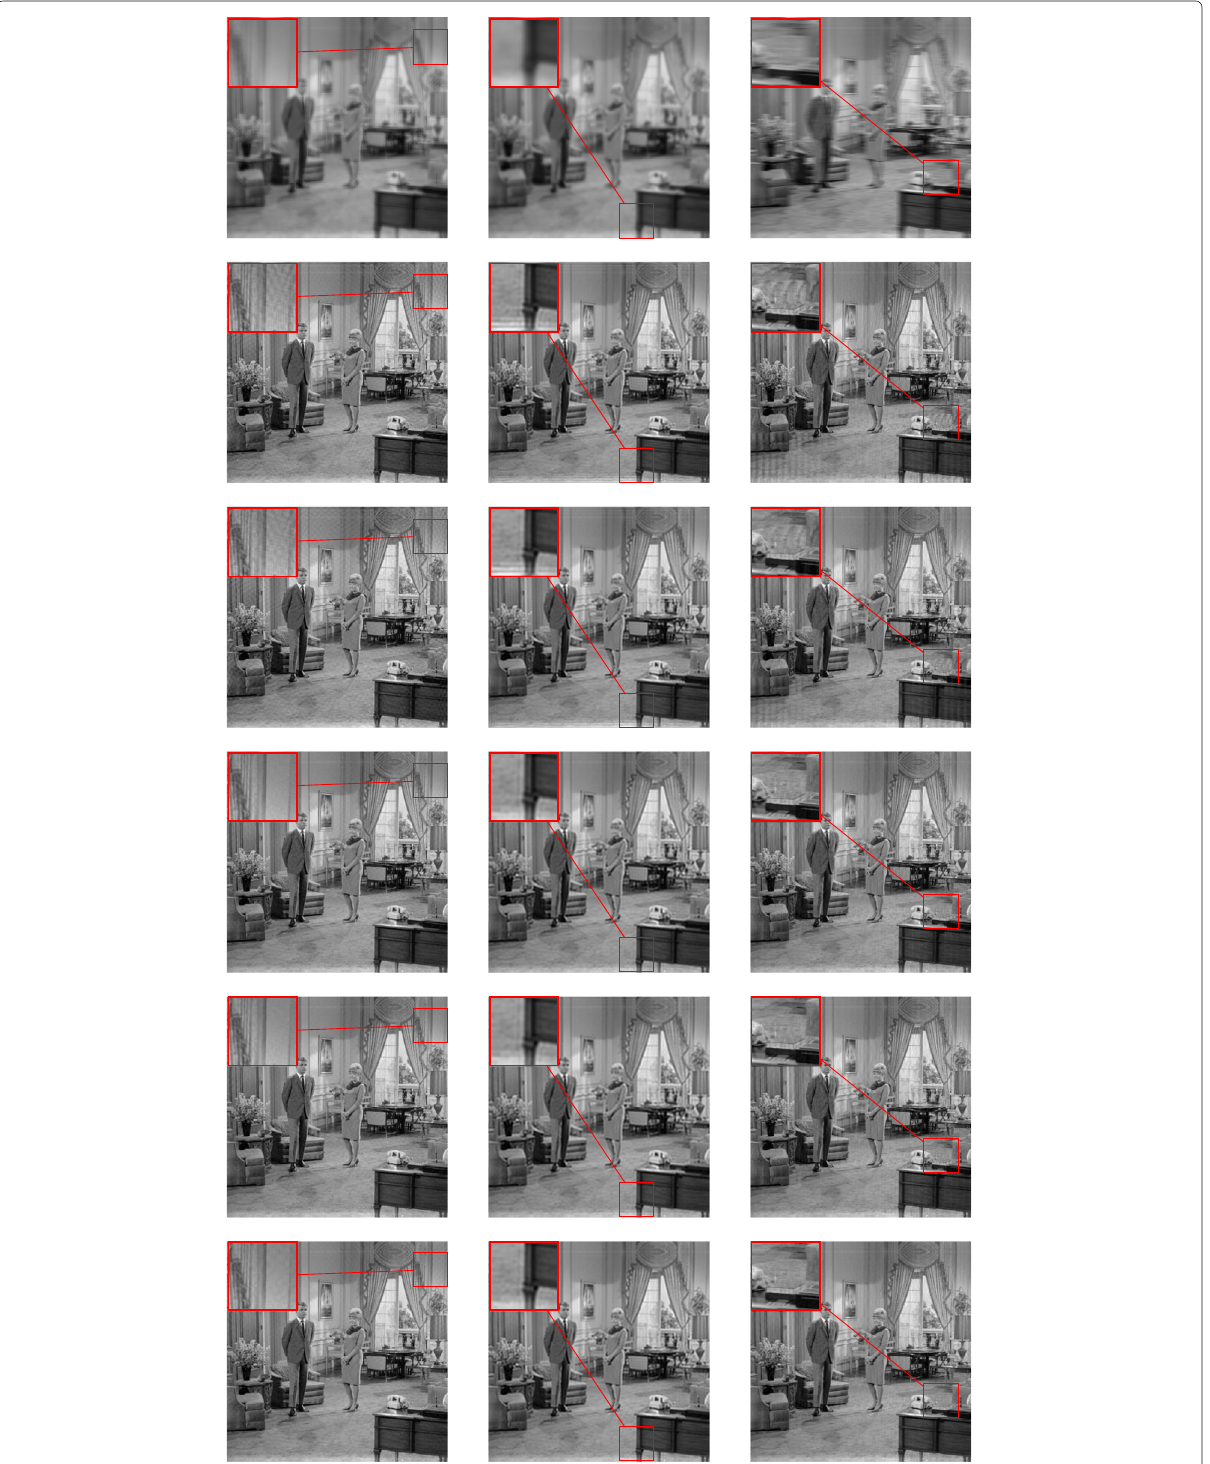
Fig. 6 Deconvolution of Couple image. From left to right, the first column represents degradation by kernel 1, the second column for the degradation by kernel 2, and by kernel 3 in the third column. From top to bottom, the order of the rows is as follows: blurred images using the three kernels respectively, restored images using RL algorithm [11] (kernel 1 (iterations = 150), kernel 2 (iterations = 310), and kernel 3 (iterations = 90)), restored images using Wiener filter [9], restored images using TV method [14], restored images using BTV approach [16], and finally the restored images using our proposed MAP- H 1